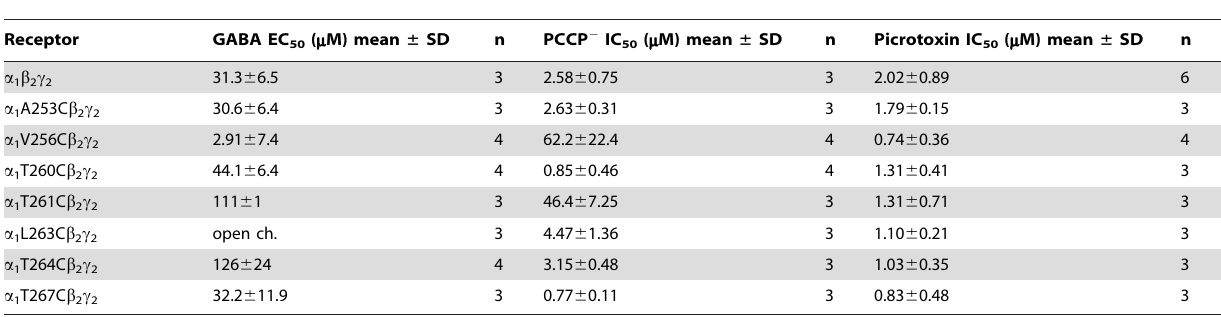
Table 1. Pharmacological evaluation of the expressed recombinant receptors.